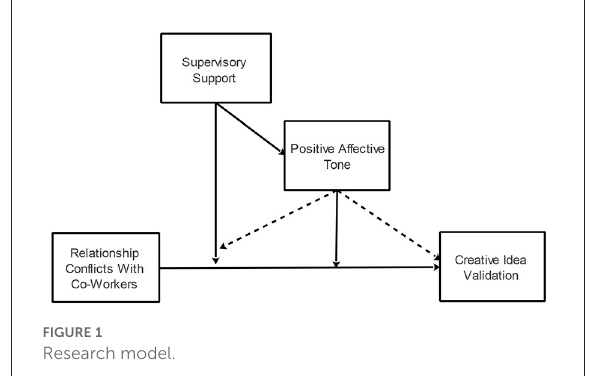
FIGURE1 Research